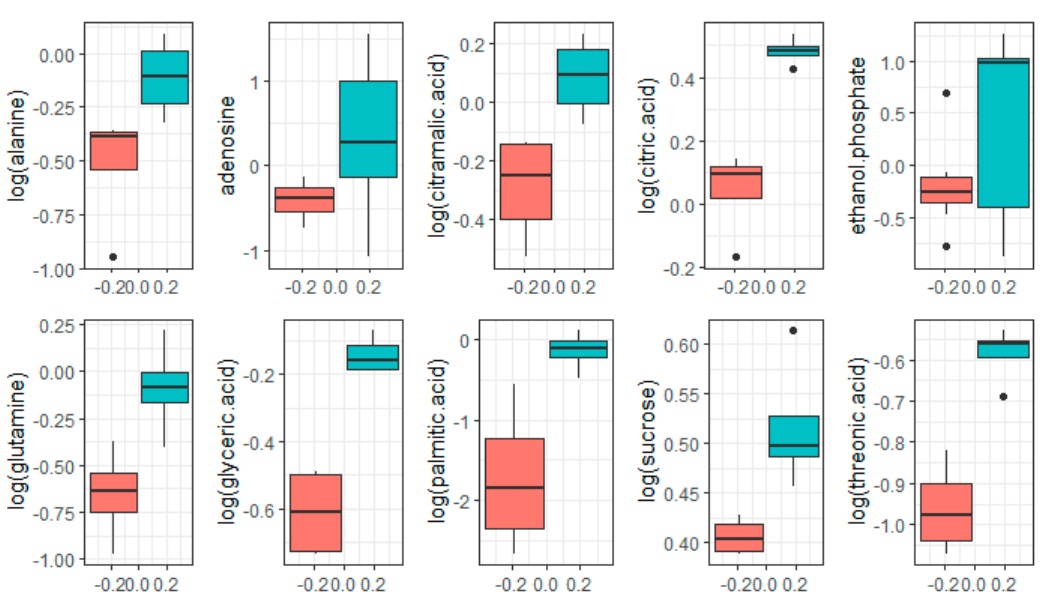
Figure 3. Boxplots of normalized peak intensity values of final known metabolites obtained from the random forest model for control and PA treatments. The data are shown in alphabetic order. The figure was created using R software. Bold dotes denote outliers.